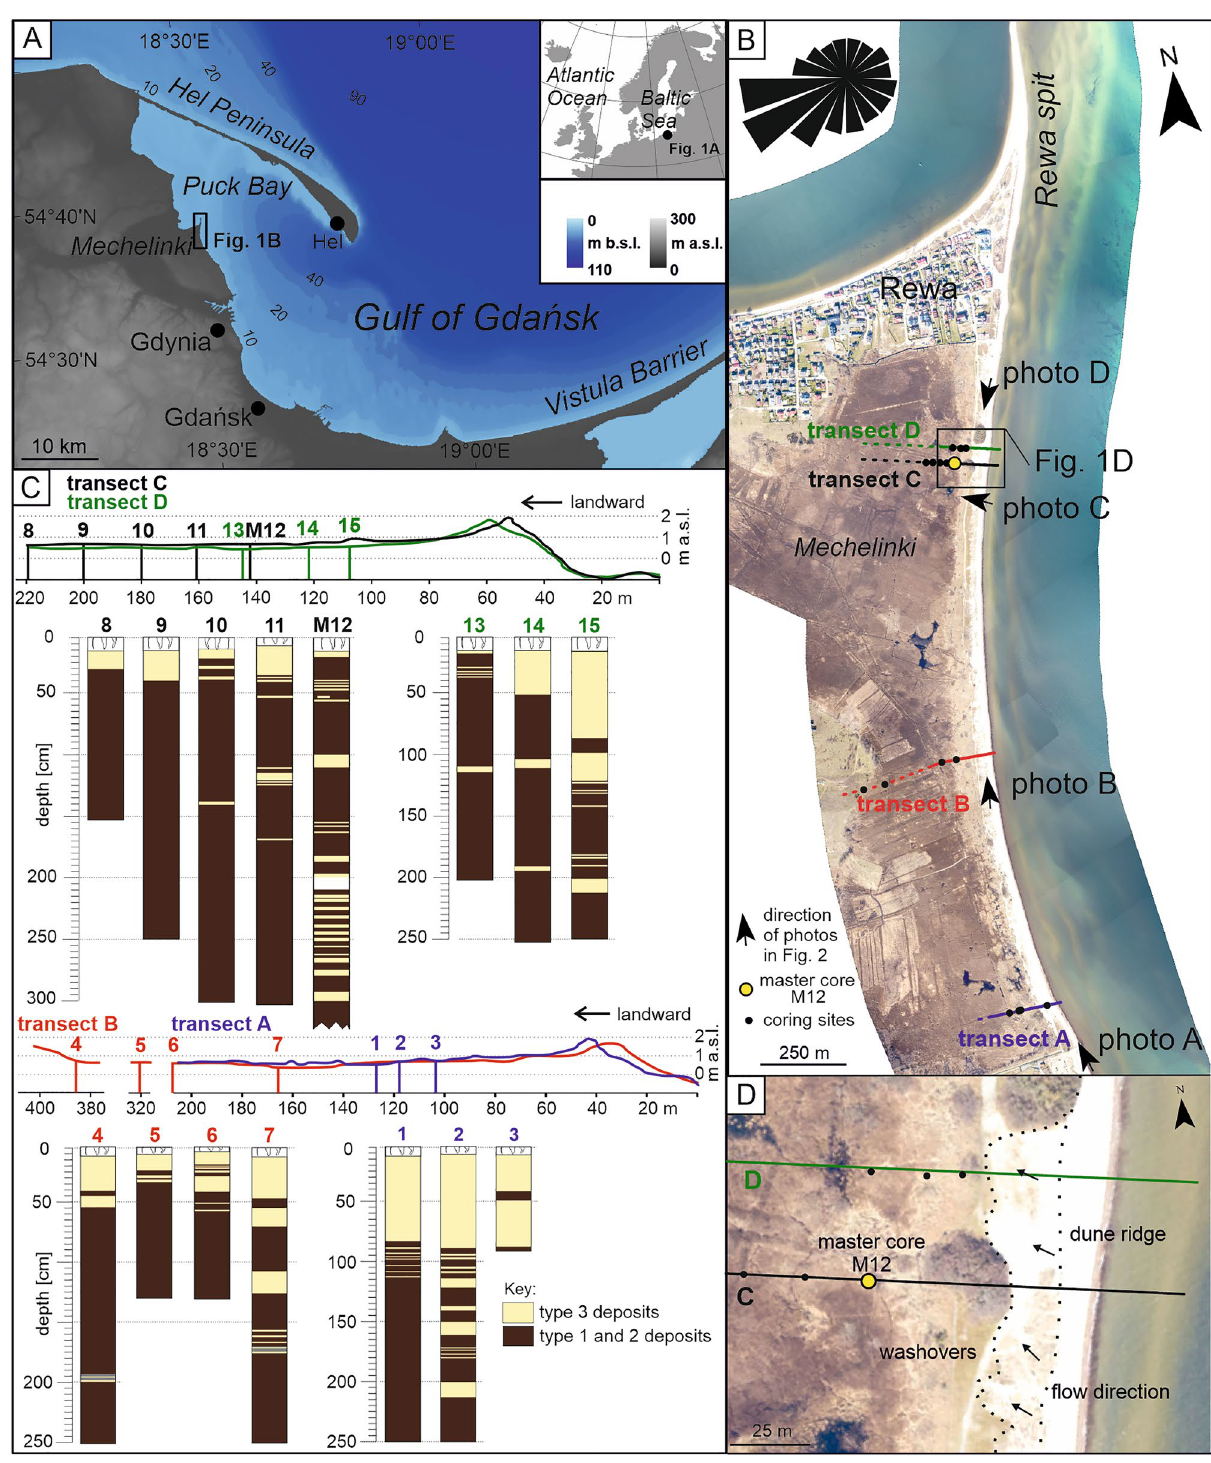
Figure 1. Location of the research area. ( A ) Mechelinki research area at the southern Baltic Sea coast (Poland), Puck Bay within the Gulf of Gdańsk. ( B ) Orthophoto map of the Mechelinki area with locations of coring sites and geological cross-sections. ( C ) Geological cross-sections through the depositional succession at Mechelinki, with deposits of type 1–3. ( D ) Close-up of recent wash-over fans (landward limit marked with dotted line). Bathymetric data: EMODnet service, resolution115 m; DEM: European Environmental Agency, hybrid model based on SRTM and ASTER GDEM with a spatial resolution of 30 m. Windrose predicting frequency of wind directions: https:// www. meteo blue. com. Figure was created with CorelDRAW Graphics Suite 2019 (Corel Corporation: https:// www. corel. com/ en/ old- versi ons/ corel draw-